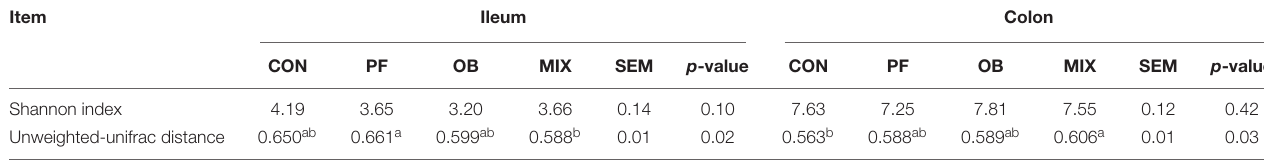
TABLE 1 | The α - and β -diversity of microbial community in the digesta samples from ileum and colon of pigs in CON, PF, OB, and MIX groups 1 . Item Ileum Colon CON PF OB MIX SEM p -value CON PF OB